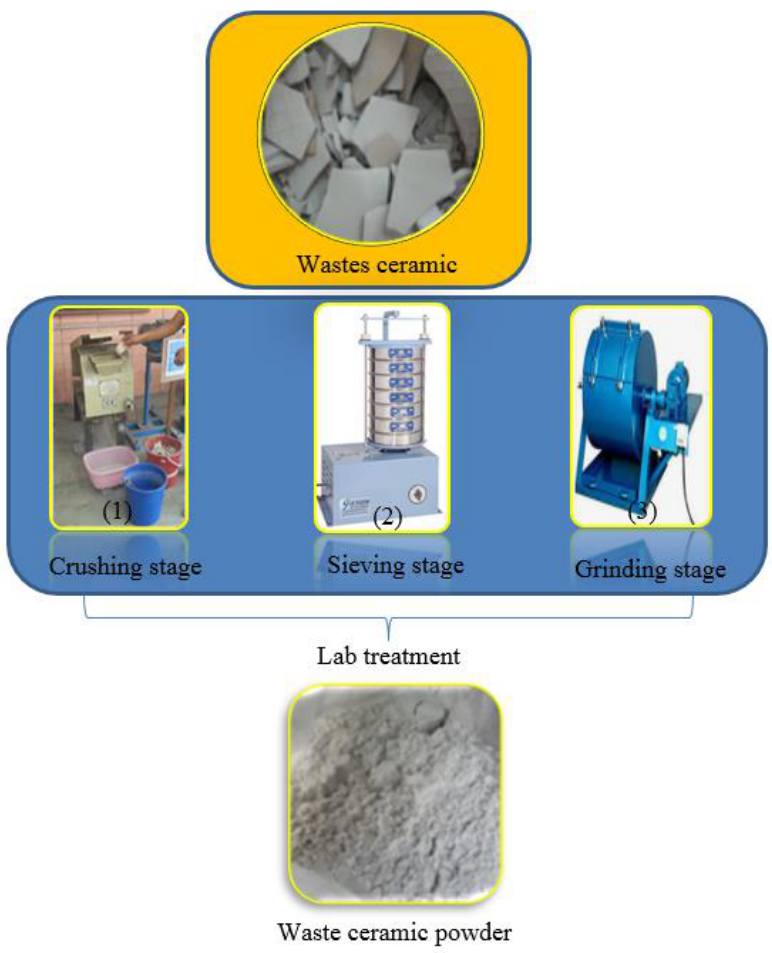
Figure 1. TCWs preparation stages.